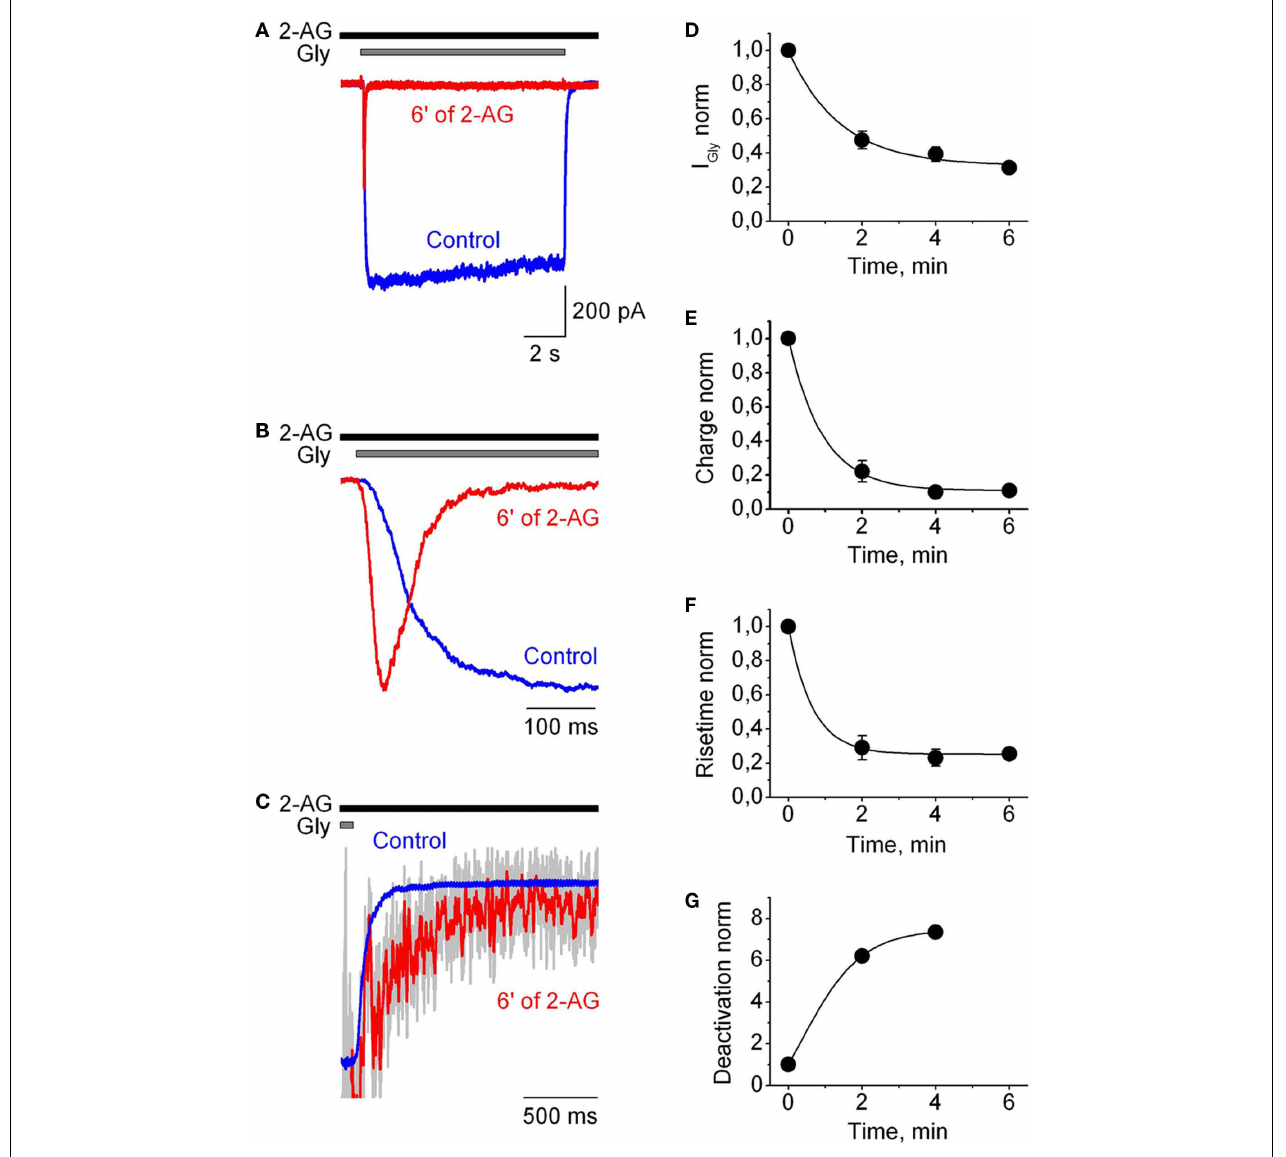
FIGURE 1 | Modulation of human GlyR α 1H-mediated currents by 2-AG in outside-out patches. (A) Representative traces of I Gly , induced by 50 μ M Gly, recorded in outside-out patch-clamp configuration in control (blue) and in the presence of 1 μ M 2-AG (red). Here and below representative traces correspond to the saturation of the effects of 2-AG. (B) Superimposed and normalized traces shown in (A) at expanded time scale to illustrate 2-AG-induced changes in the rise time of I Gly .